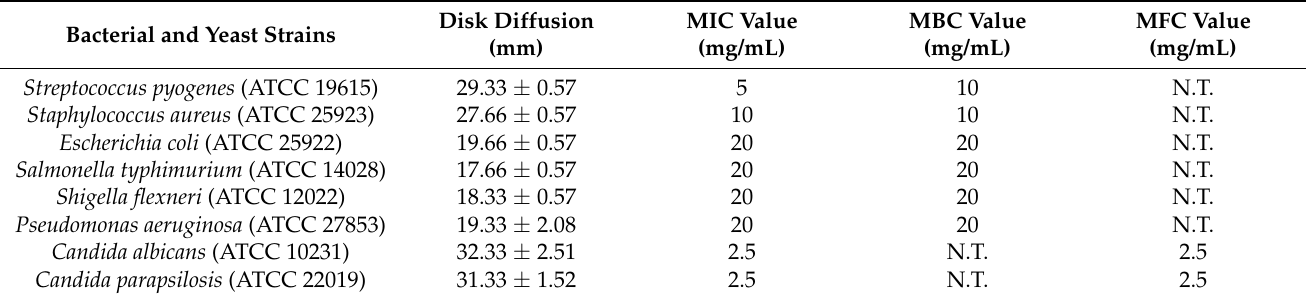
Table 4. Antimicrobial of the essential oil of M. smithiana growing in Western Romania by disk diffusion, minimum inhibitory concentration (MIC), minimum bactericidal concentration (MBC), and minimum fungicidal concentration (MFC) 1 . Disk Diffusion MIC Value MBC Value MFC Value Bacterial and Yeast Strains (mm) (mg/mL) (mg/mL) (mg/mL) Streptococcus pyogenes (ATCC 19615) 29.33 ± 0.57 5 10 N.T. Staphylococcus aureus (ATCC 25923) 27.66 ± 0.57 N.T. Escherichia coli (ATCC 25922) 19.66 ± 0.57 N.T. Salmonella typhimurium (ATCC 14028) 17.66 ± 0.57 20 N.T. Shigella flexneri (ATCC 12022) 18.33 ± 0.57 20 20 N.T. Pseudomonas aeruginosa (ATCC 27853) 19.33 ± 2.08 20 20 N.T. Candida albicans (ATCC 10231) 32.33 ± 2.51 2.5 N.T. 2.5 Candida parapsilosis (ATCC